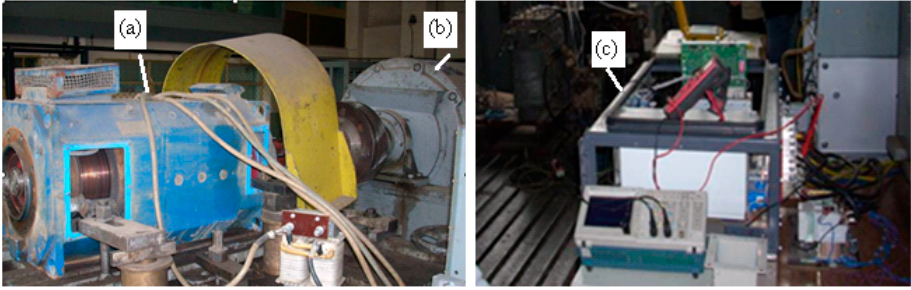
Figure 6. A 150 kW D.C. motor ( a ); asynchronous generator ( b ); chopper used to supply the motor ( c ).